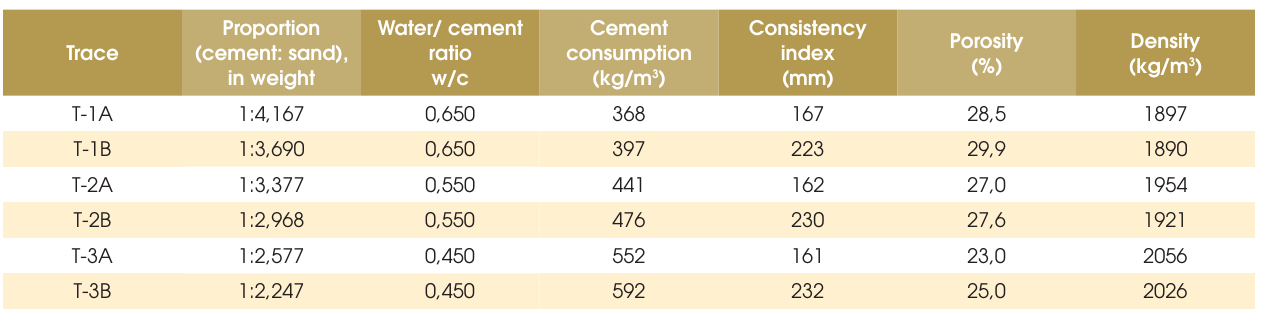
Table 2 – Fresh-state mortar composition and specifications